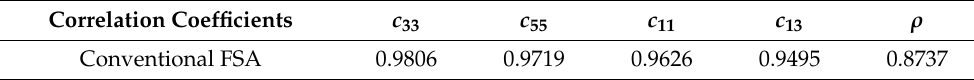
Table 2. Correlation coefficients of the inversion results in Figure 11a and the true models.